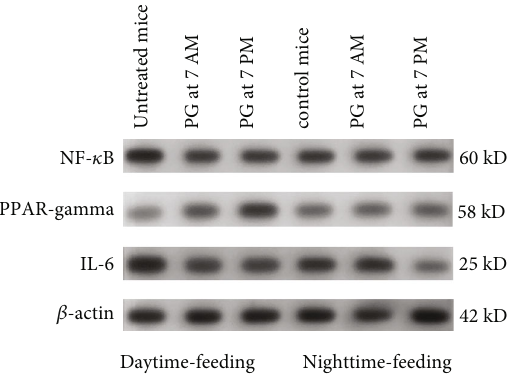
Figure 4: Western blot results of PPAR- γ , pNF- κ B, and IL-6 expression in the liver tissue of experimental